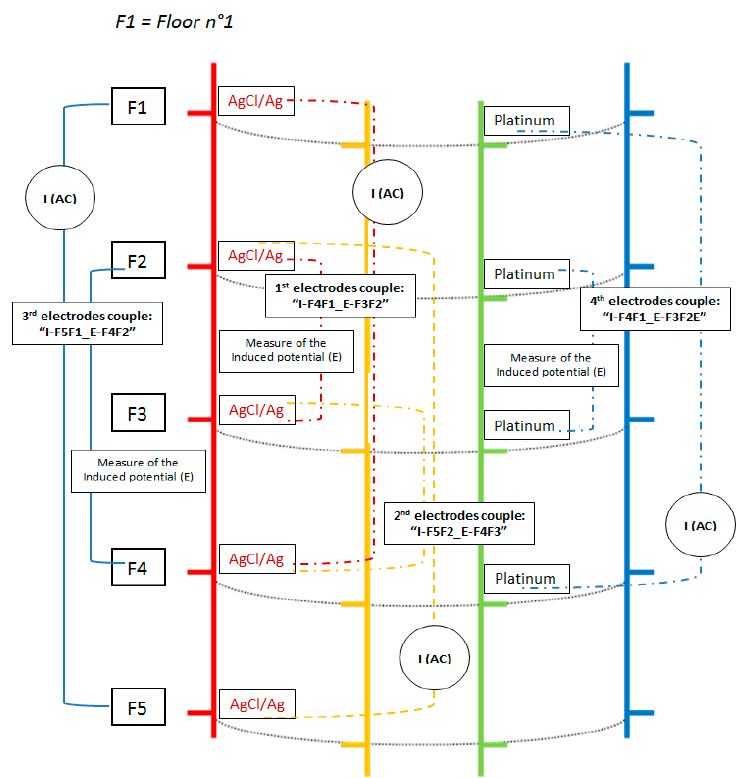
Figure 3. Schematic representation of the multi-parameter probe as well as the different electrode couples used for conductivity measurements.